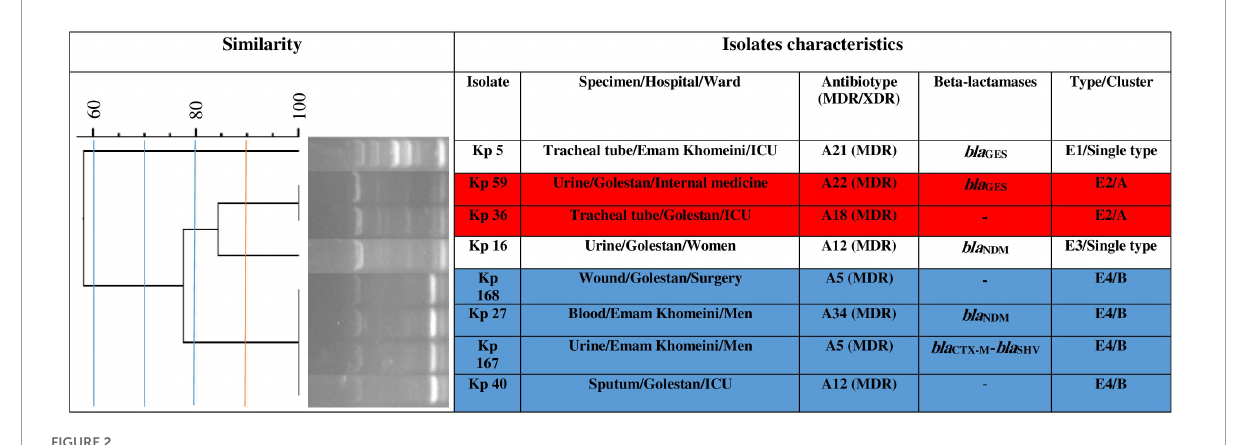
FIGURE2 Clonal relatedness of eight carbapenem-resistant hypervirulent Klebsiella pneumoniae using ERIC-PCR. Based on the UPGMA and Dice similarity coefficient, the isolates were assigned to two clusters and three